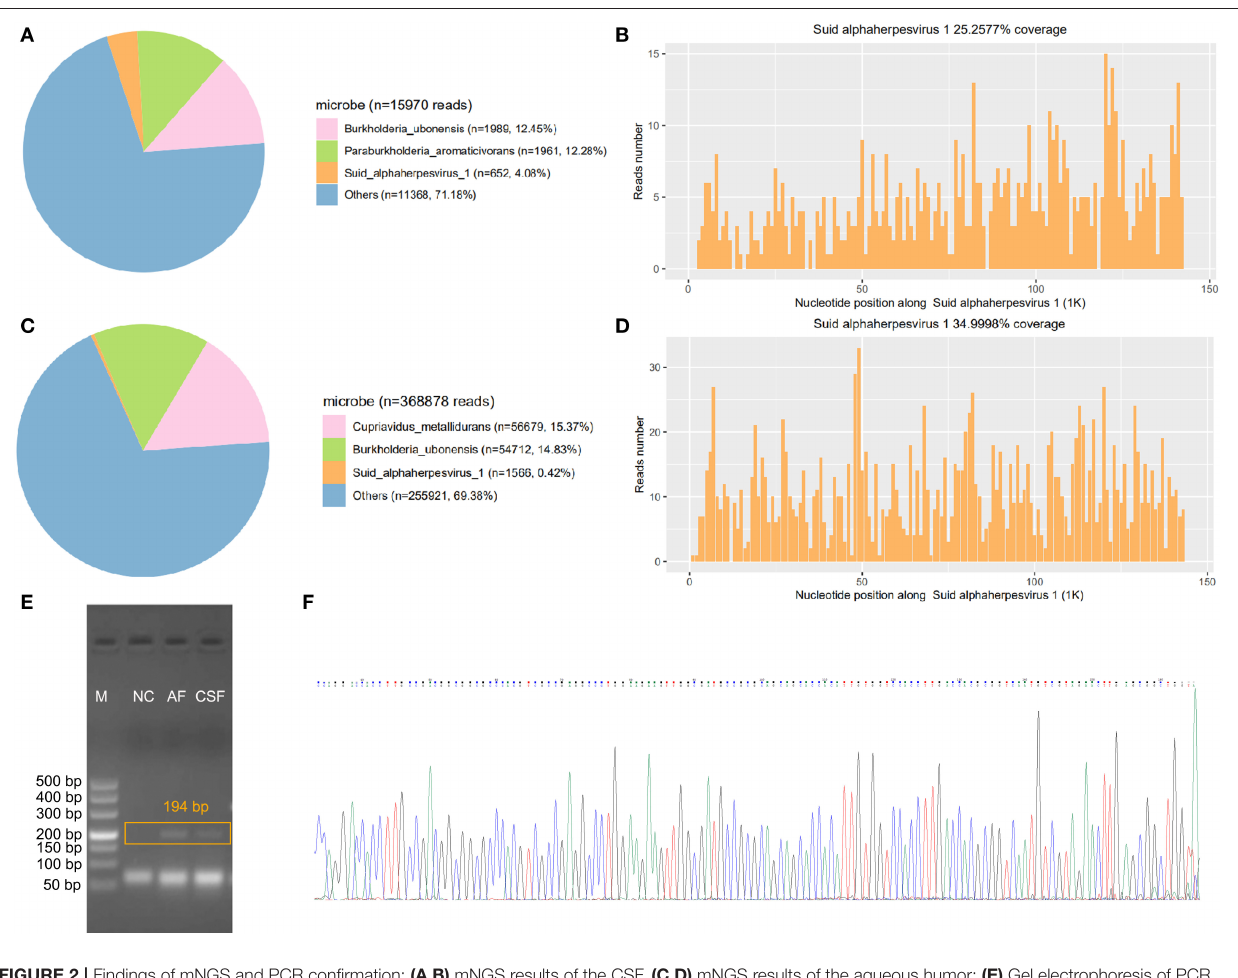
FIGURE 2 | Findings of mNGS and PCR confirmation; (A,B) mNGS results of the CSF. (C,D) mNGS results of the aqueous humor; (E) Gel electrophoresis of PCR products; (F) Sanger sequencing result; Genome coverage rate is total length of detected sequences dividing by the length of published genome sequence. The “AH,” “CSF,” “NC,” and “M” represent aqueous humor, cerebrospinal fluid, negative control, and marker,